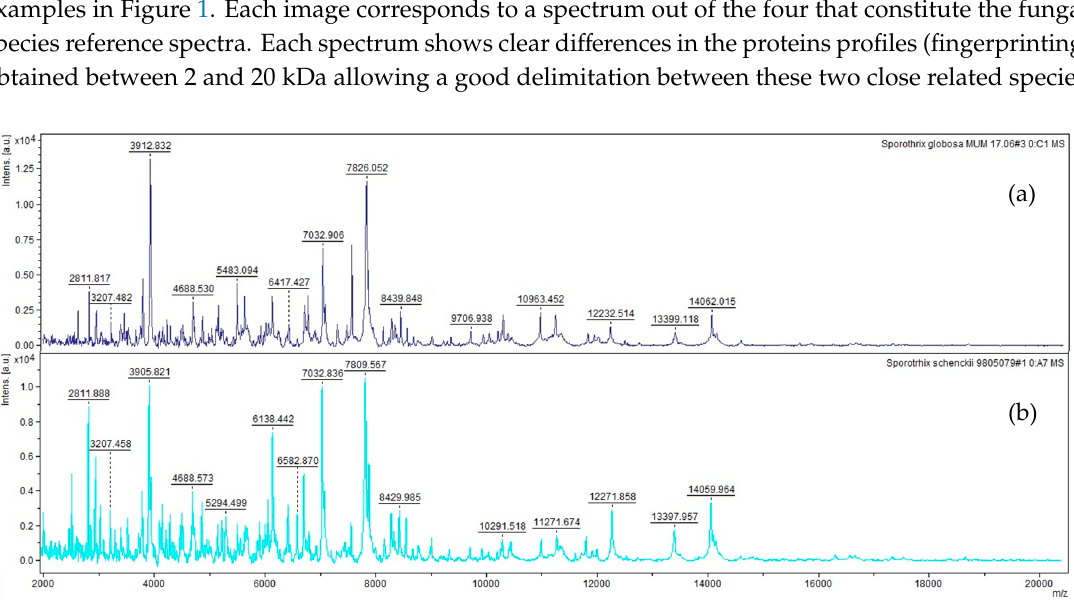
Figure 1. References spectra between 2 and 20 kDa of ( a ) S. globose and ( b ) S. schenckii s.s.